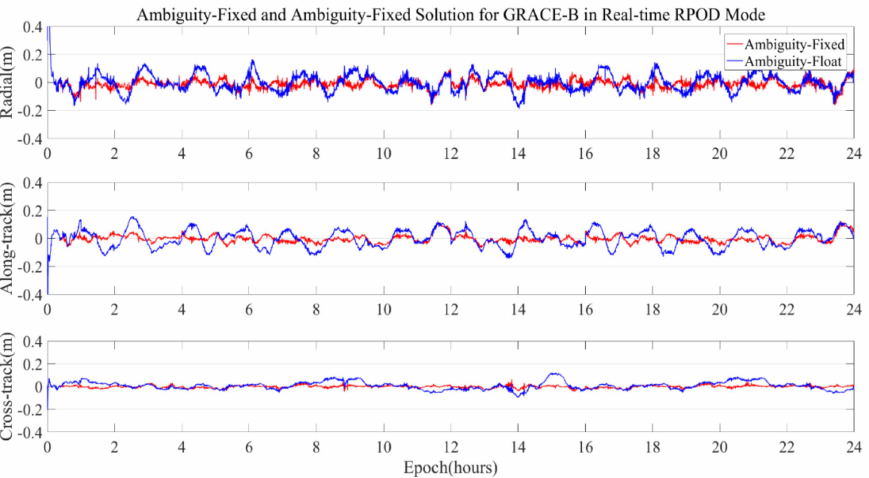
Figure 8. Orbital differences of GRACE-B ambiguity-fixed and ambiguity-float RPOD based on comparison with reference